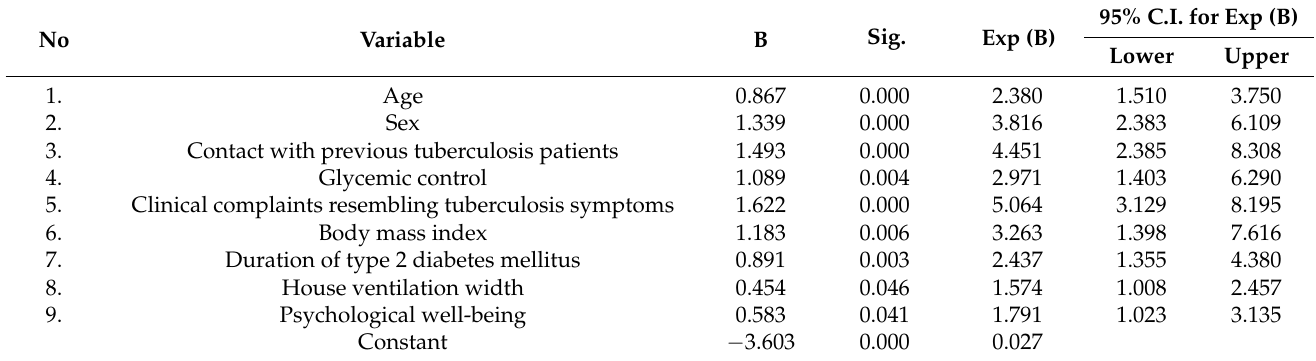
Table 3. Multiple logistic regression test results before tuberculosis predictive index on type 2 diabetes mellitus compilation with statistically significant